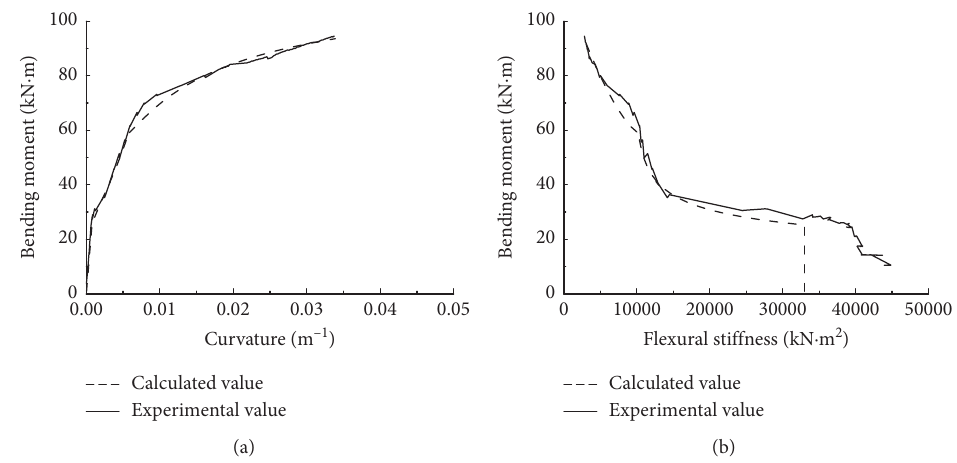
Figure 17: Beam B-1-20-4. (a) Bending moment-curvature curve. (b) Bending moment-stiffness curve.